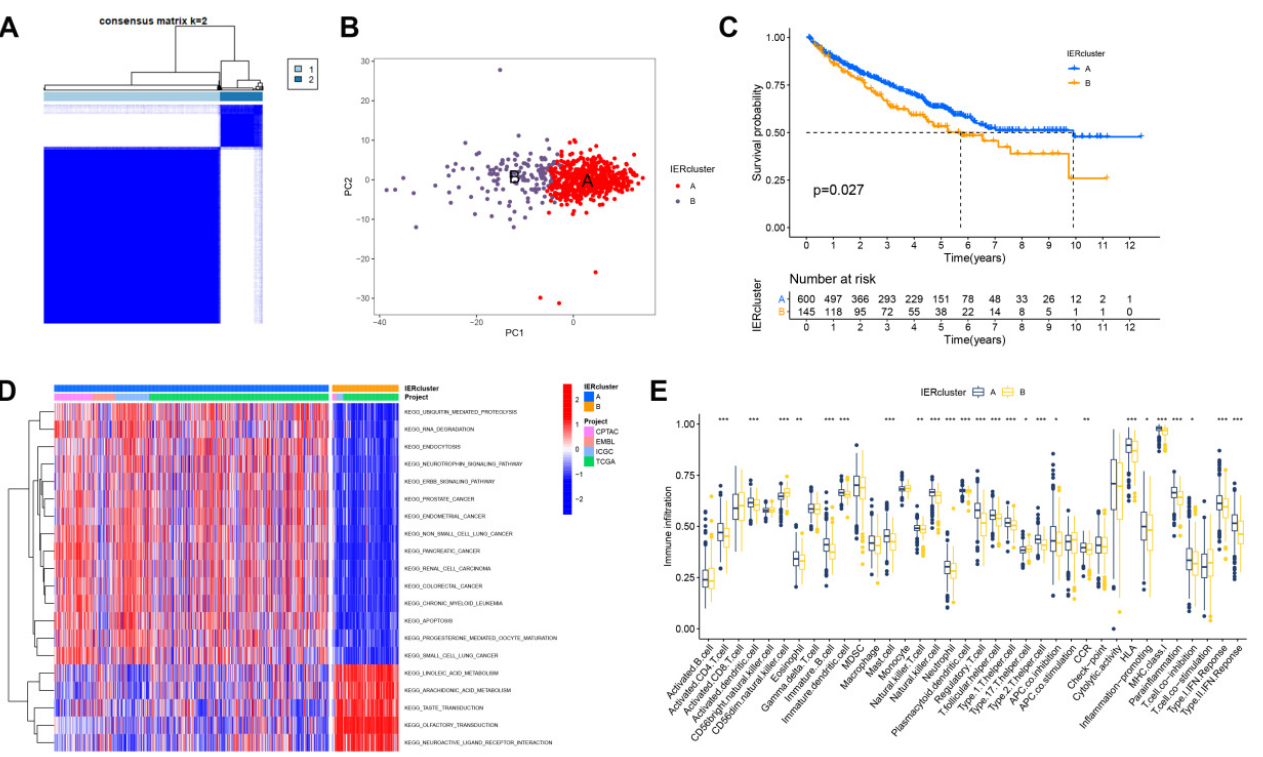
Figure 2. Identification of immune escape clusters. ( A , B ) Consensus clustering of ccRCC samples based on immune escape genes. ( C ) Overall survival curves of IER A and IER B clusters using the Kaplan–Meier method. ( D ) Heatmap of biological differences between IER A and IER B clusters. ( E ) Differences in tumor immune microenvironment composition between IER A and IER B clusters (*: p < 0.05; **: p < 0.01; ***: p < 0.001).